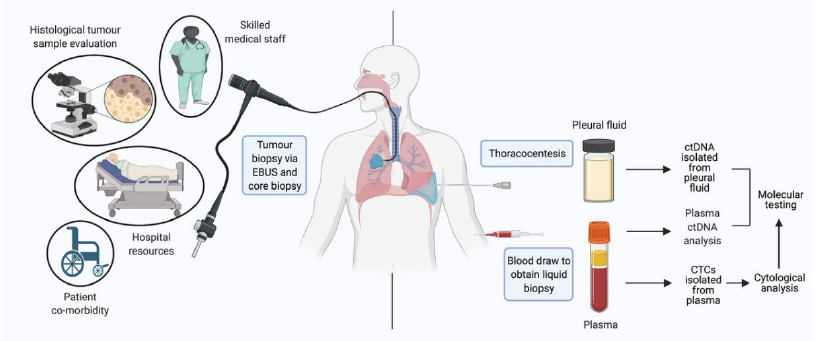
Figure 1. Technical considerations when acquiring tumor tissue and liquid biopsy specimens and preparing samples for diagnostic and monitoring purposes in NSCLC. Core tissue biopsy and EBUS requires careful consideration of patient factors such as comorbidity and frailty, and may be complicated by procedure risk. Technically skilled medical staff and significant healthcare resources are required for such procedures, which limits their availability. Acquisition of sufficient material for diagnosis, subtyping and molecular subtyping is not always straightforward and can lead to delays in “real-world” practice. Sample collection for liquid biopsy is minimally invasive, via blood draw or pleural fluid analysis, technically straightforward and minimizes patient risk. NSCLC = non-small cell lung carcinoma; EBUS = endobronchial ultrasound; CTCs = circulating tumor cells; ctDNA = circulating tumor